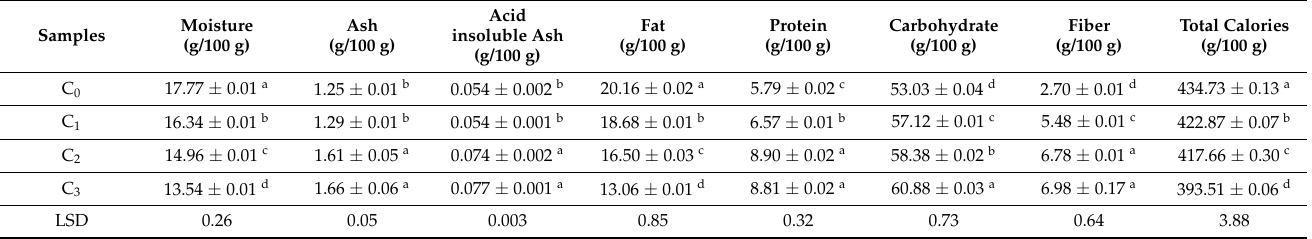
Table 3. Proximate composition of the MOLP and RBF fortified